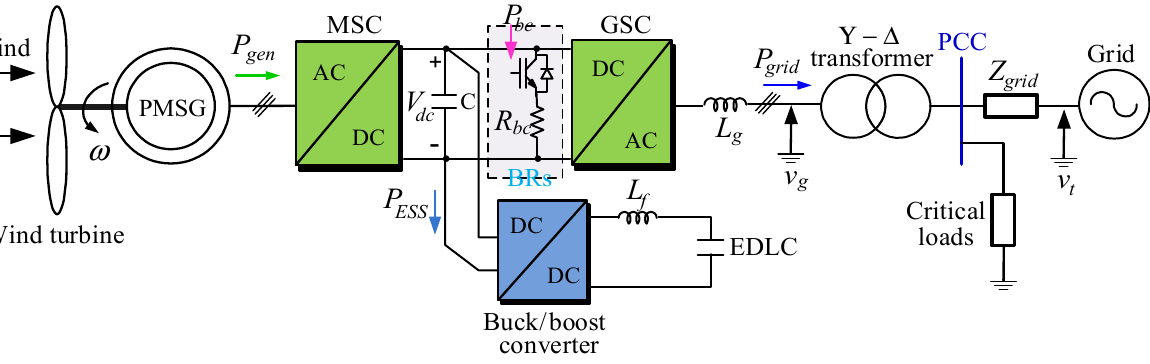
Figure 1. WTS with PMSG utilizes a hybrid scheme of ESSs and BRs in the distribution system [17].